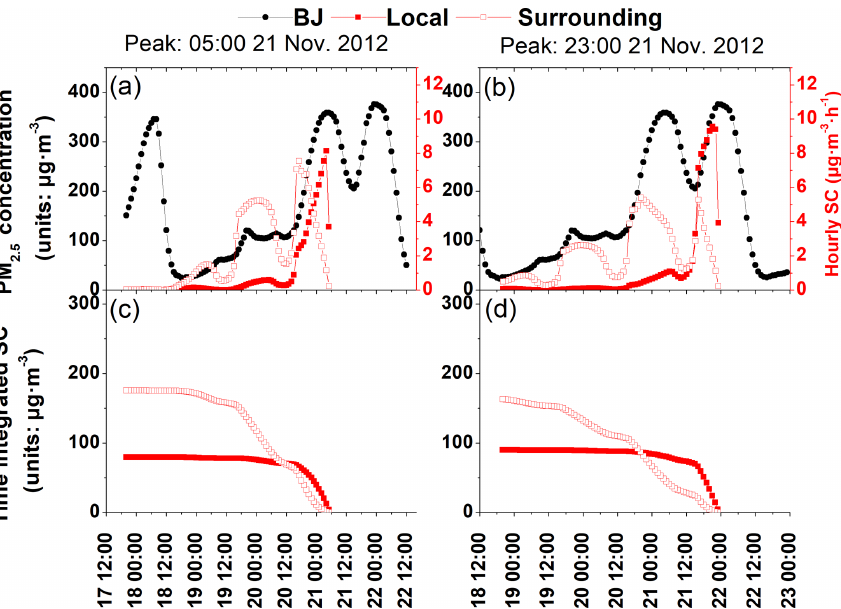
Figure 11. Hourly variations of surface PM 2 . 5 concentrations in Beijing and sensitivity coefficients of surface PM 2 . 5 concentration peaks in Beijing to local and surrounding primary PM 2 . 5 sources. The left and right panels correspond to PM 2 . 5 concentration peaks at 05:00 and at 23:00LT on 21 November 2012, respectively. (a–b) Hourly variations of Beijing PM 2 . 5 concentrations (black solid dotted line) and hourly instantaneous sensitivity coefficients to local (solid red squares) and surrounding (red open squares) emission sources. (c–d) The time-integrated sensitivity coefficients to local (solid red squares) and surrounding (red open squares) emission sources. Please note that the date and time are given in DD HH:MM format, with all dates in November